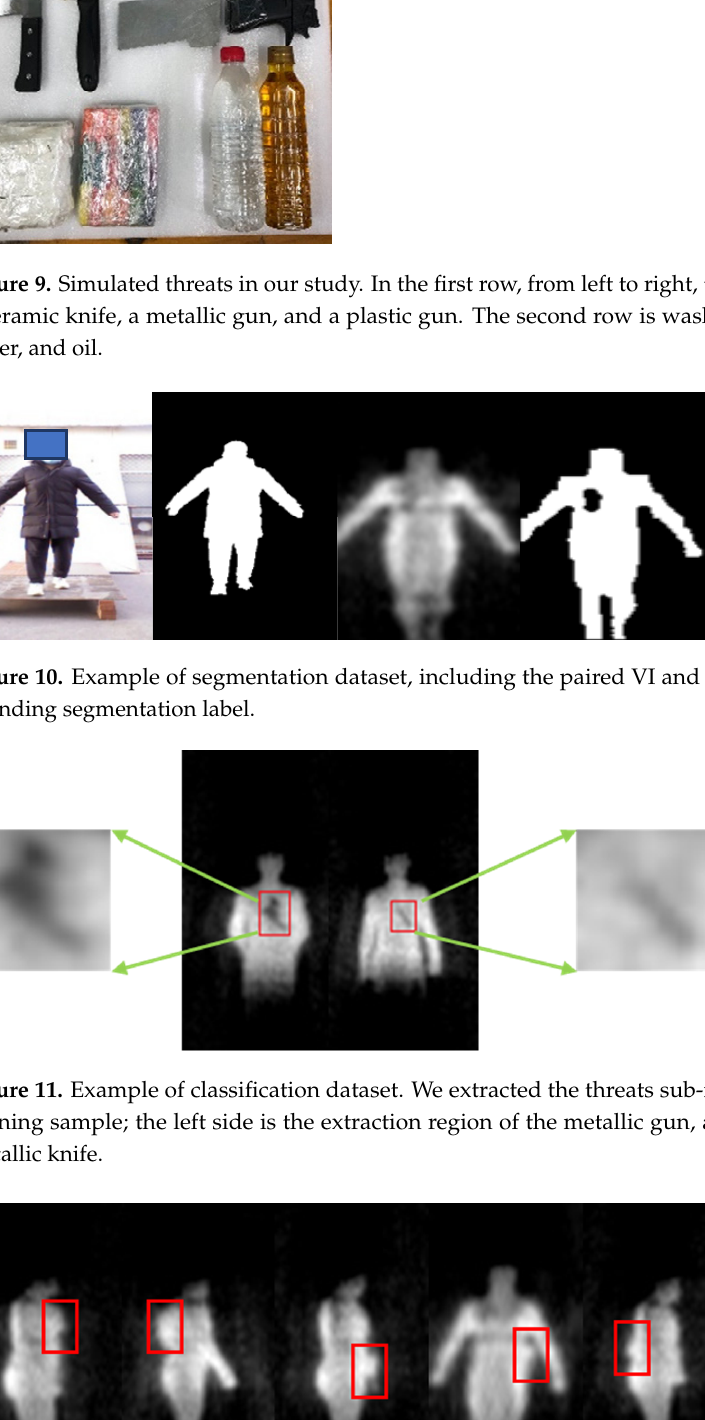
Figure 11. Example of classification dataset. We extracted the threats sub-region from PMMWI as training sample; the left side is the extraction region of the metallic gun, and the right side is the metallic knife. Figure 12. Example of anomaly detection dataset. The area contained in the bounding box is the abnormal area caused by the threats. abnormal area caused by the